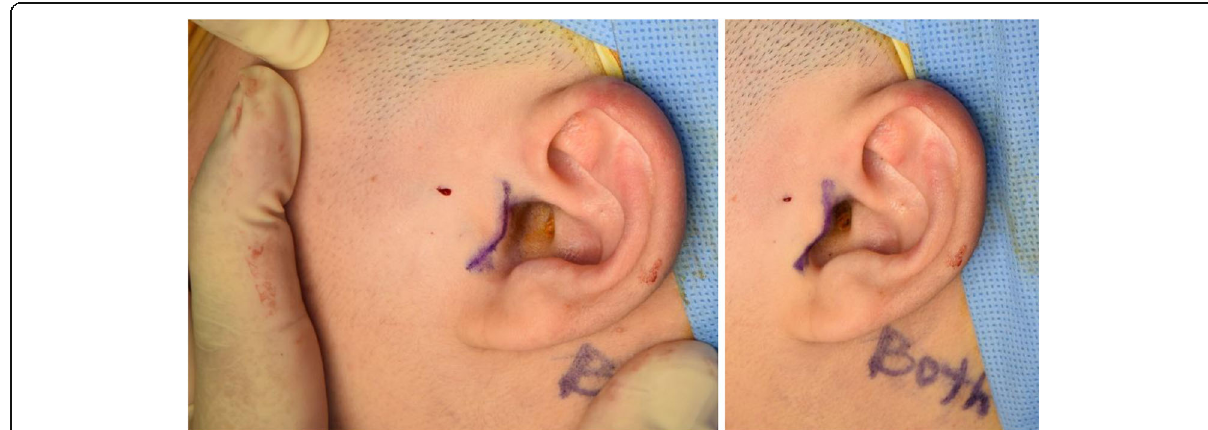
Fig. 2 Anterior digital traction for initial surgical markings with methylene blue. a Modified short endaural approach marked with methylene blue when digital traction is released b showing how the incision is hidden